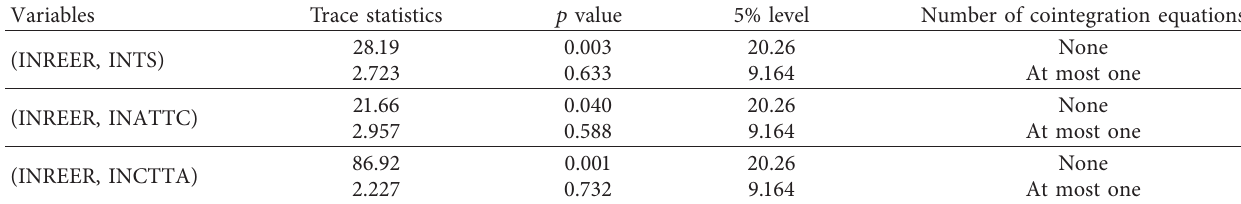
Table 2: Cointegration test